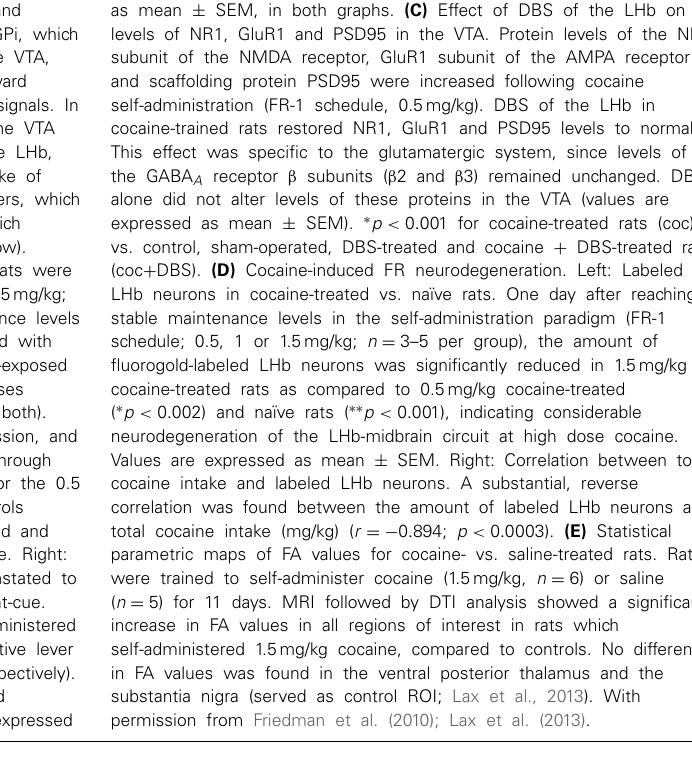
FIGURE 1 | (A) Scheme representing the main LHb afferents and efferents. Left: The LHb receives excitatory inputs from the GPi, which encode for aversion. The LHb subsequently fires to inhibit the VTA, which is the main dopaminergic source that activates the reward system. Thus, the GPi-LHb pathway creates negative reward signals. In contrast, when a positive reward is predicted or presented, the VTA activates the reward system and also inhibits its regulator, the LHb, thus encoding for positive reward signal. Right: Repeated intake of cocaine dose-dependently degenerate the main LHb-to-VTA fibers, which comprise the FR. This ceases LHb regulation of the VTA, which consequently renders LHb DBS ineffective at high doses (below). (B) Left: Effects of LHb DBS on cocaine-seeking behaviors. Rats were allowed to self-administer cocaine (FR-1 schedule; 0.5, 1 or 1.5mg/kg; n = 15, 6, and 9, respectively). After reaching stable maintenance levels (day M), rats from each group were divided and either treated with DBS or sham (dayM + DBS). 0.5mg/kg and 1mg/kg cocaine-exposed groups treated with DBS showed decreased active lever presses compared to the DBS-treated 1.5mg/kg group ( ∗ p < 0 . 001 for both). DBS treatment was given again during the first extinction session, and extinction responding was measured for 6 days (E1 + DBS through E6). A significantly accelerated rate of extinction was found for the 0.5 and 1mg/kg DBS-treated groups compared to respective controls ( ∧ , # p < 0 . 001). No changes were found between DBS-treated and sham operated rats trained to self-administer 1.5mg/kg cocaine. Right: Effect of LHb DBS on reinstatement. After E6, rats were reinstated to cocaine by a priming cocaine injection (10mg/kg, i.p.) and light-cue. Rats which received DBS treatment on E1 and which self-administered either 0.5 or 1mg/kg cocaine showed significantly reduced active lever presses compared to controls ( ∗∗ p < 0 . 005 and ∗ p < 0 . 05, respectively). However, no differences were found between DBS-treated and sham-operated rats trained for 1.5mg/kg cocaine. Values are expressed